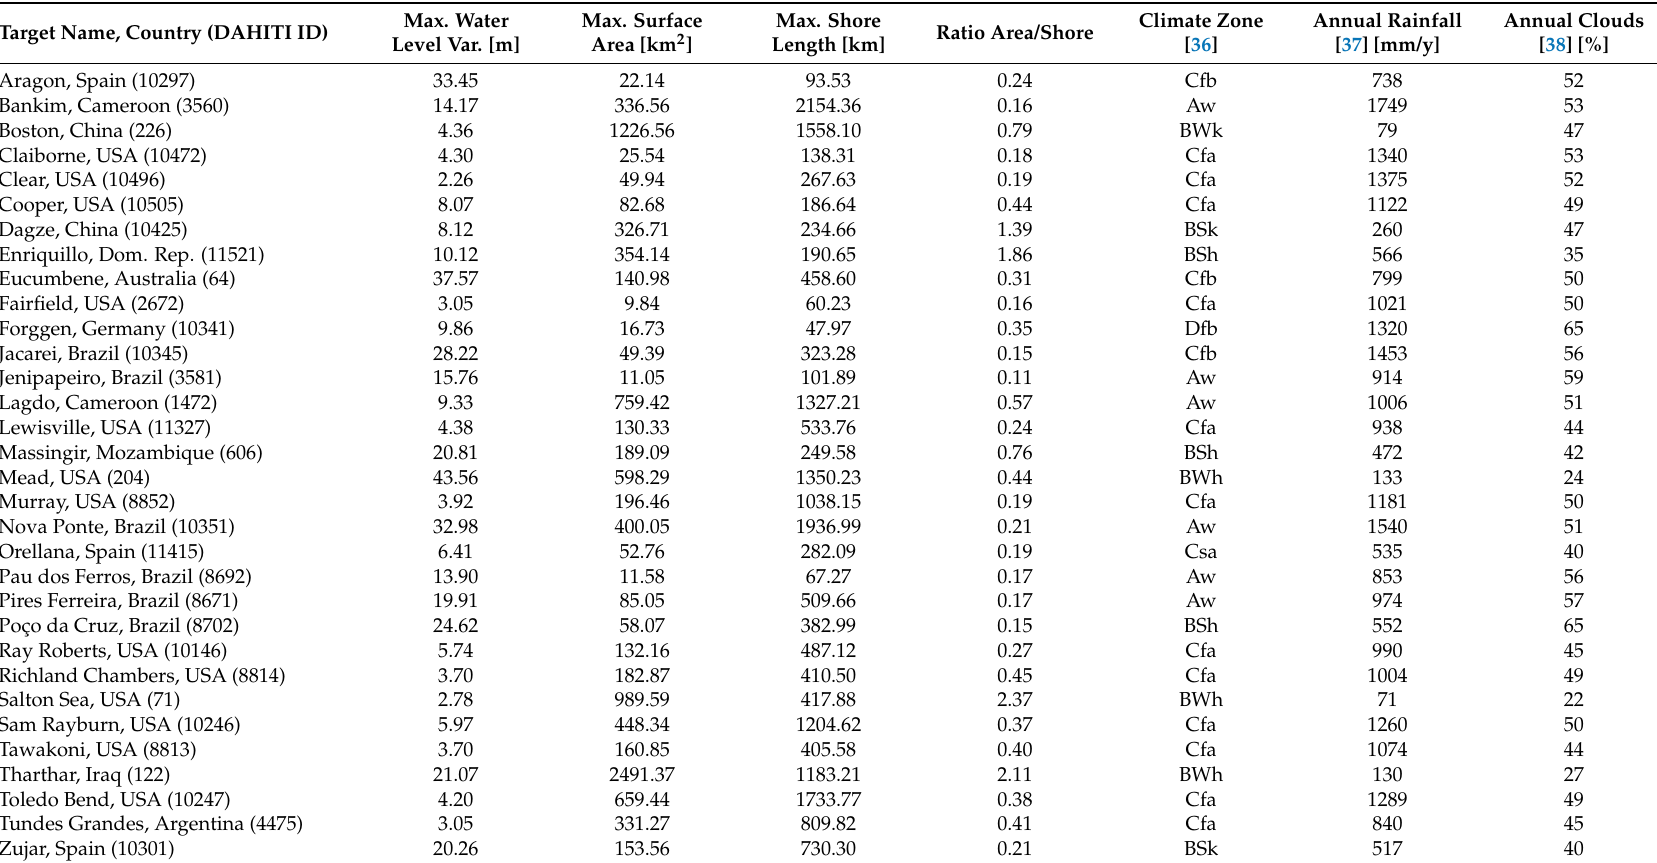
Table 4. Overview of characteristics for 32 selected study areas. For each study area, the water level variations from altimetry or gauge are given. Furthermore, the maximum surface area, length of the shore, and its ratio derived from the long-term water probability mask are shown. Additionally, information about the climate zone, annual rainfall and annual cloud coverage are